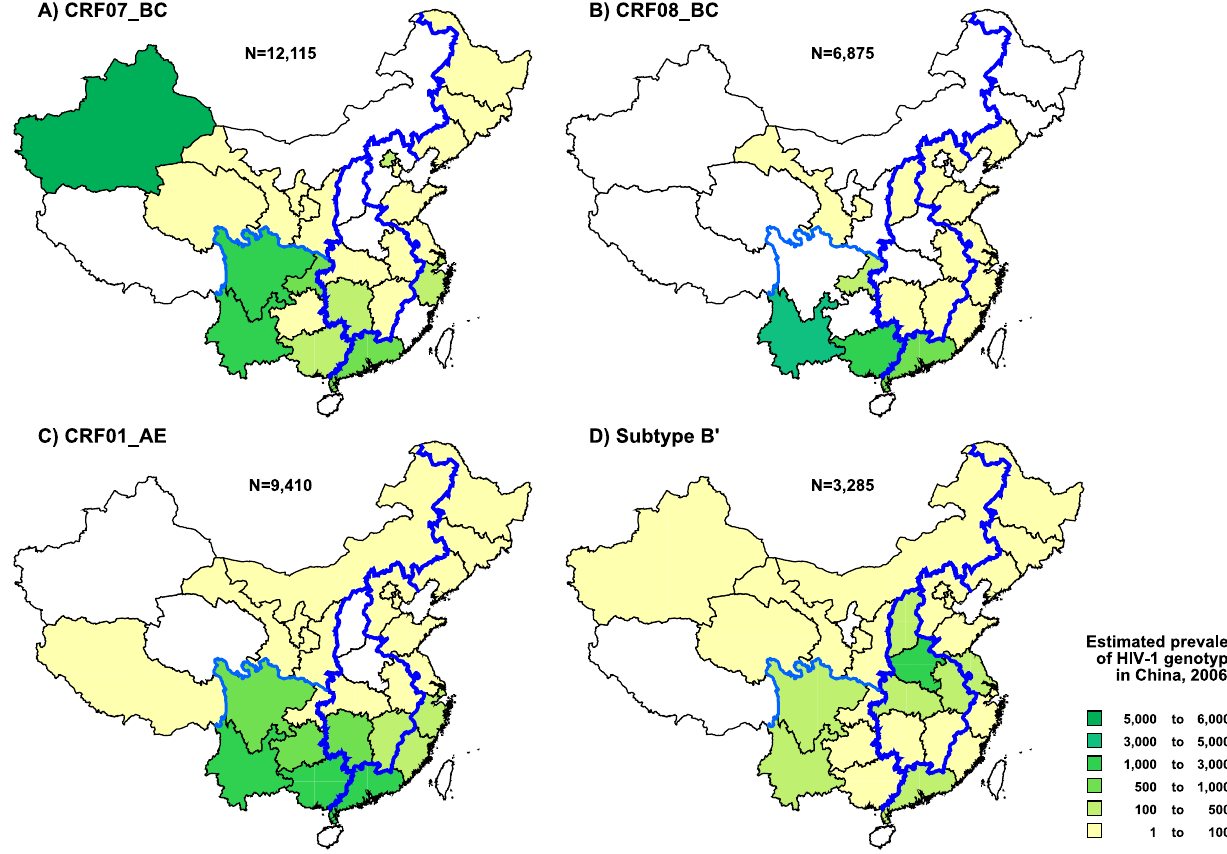
Figure 2. Estimated geographic distribution of the four major HIV-1 genotypes in China. Prevalence of the four major HIV-1 genotypes, including CRF07_BC (A), CRF08_AE (B), CRF01_AE (C) and subtype B’ (D), is estimated for each province by the methods described in Methods. Corrected prevalence is color-coded as indicated in the inset.